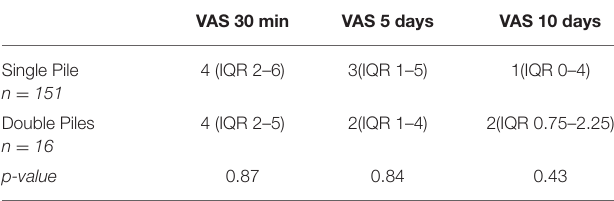
TABLE 1 | Evaluation of pain after single and double pile removal.